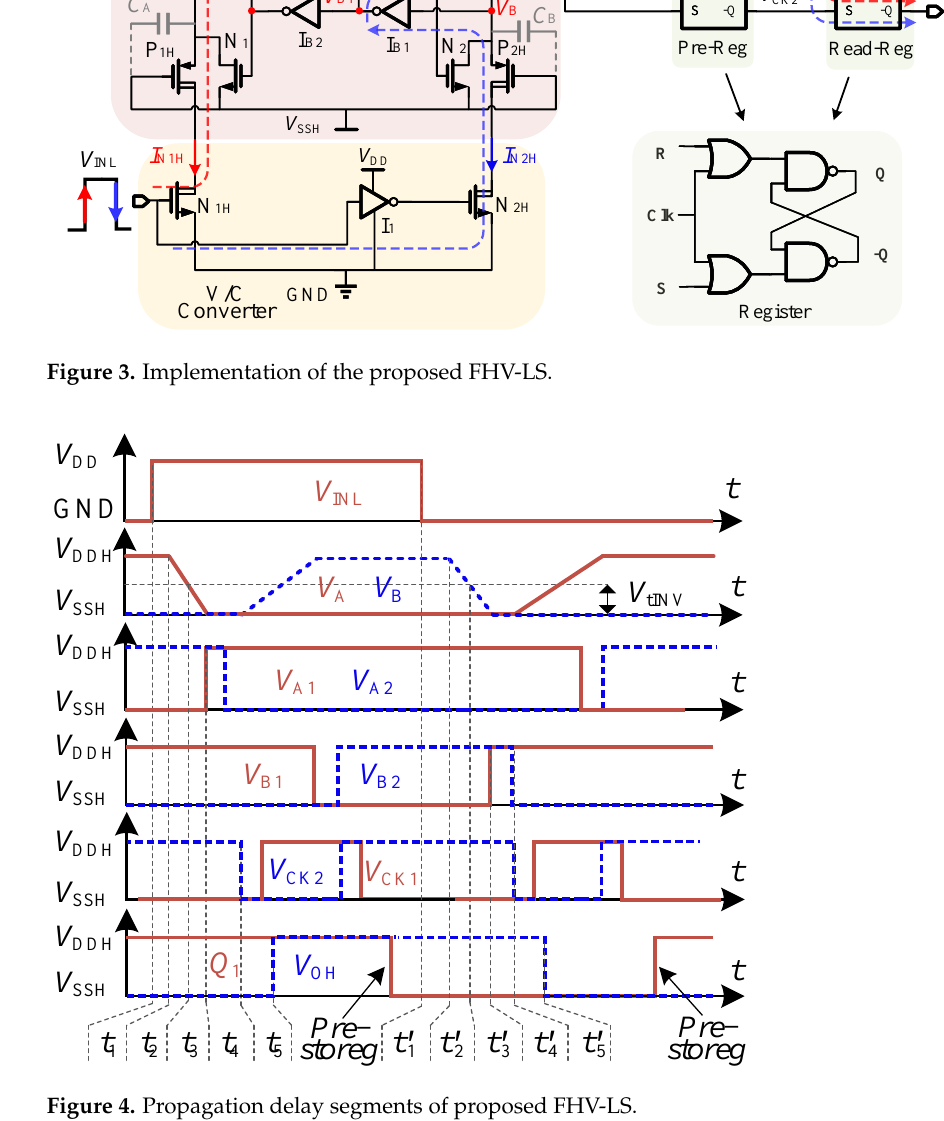
Figure 4. Propagation delay segments of proposed